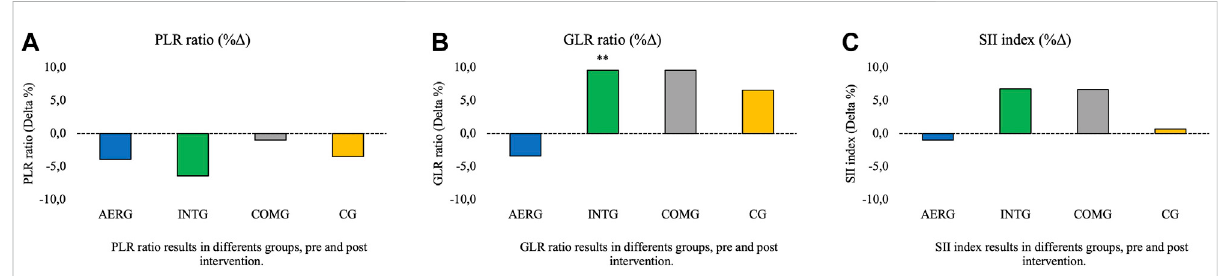
FIGURE 3 Percentage of delta (% Δ ) the difference post-pre intervention for the immune in fl ammation markers PLR ratio, GLR ratio and SII index.